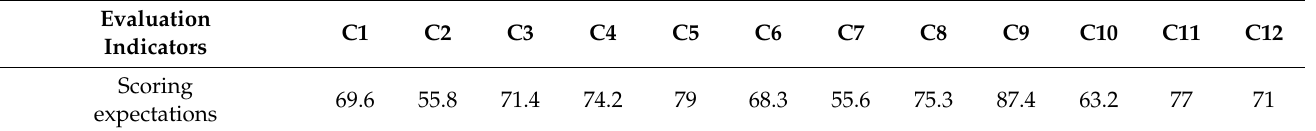
Table 16. Expert scoring expectations for each evaluation